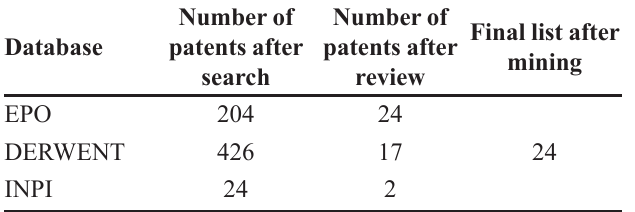
TABLE II – Quantitative results of clopidogrel polymorphic patent